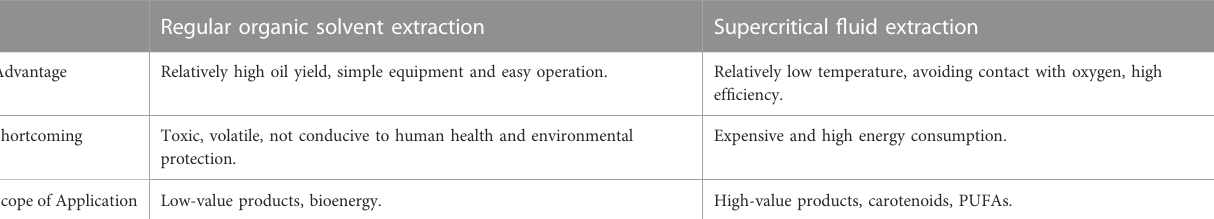
TABLE 5 Methods for oil extraction from algae. Regular organic solvent extraction Supercritical fl uid